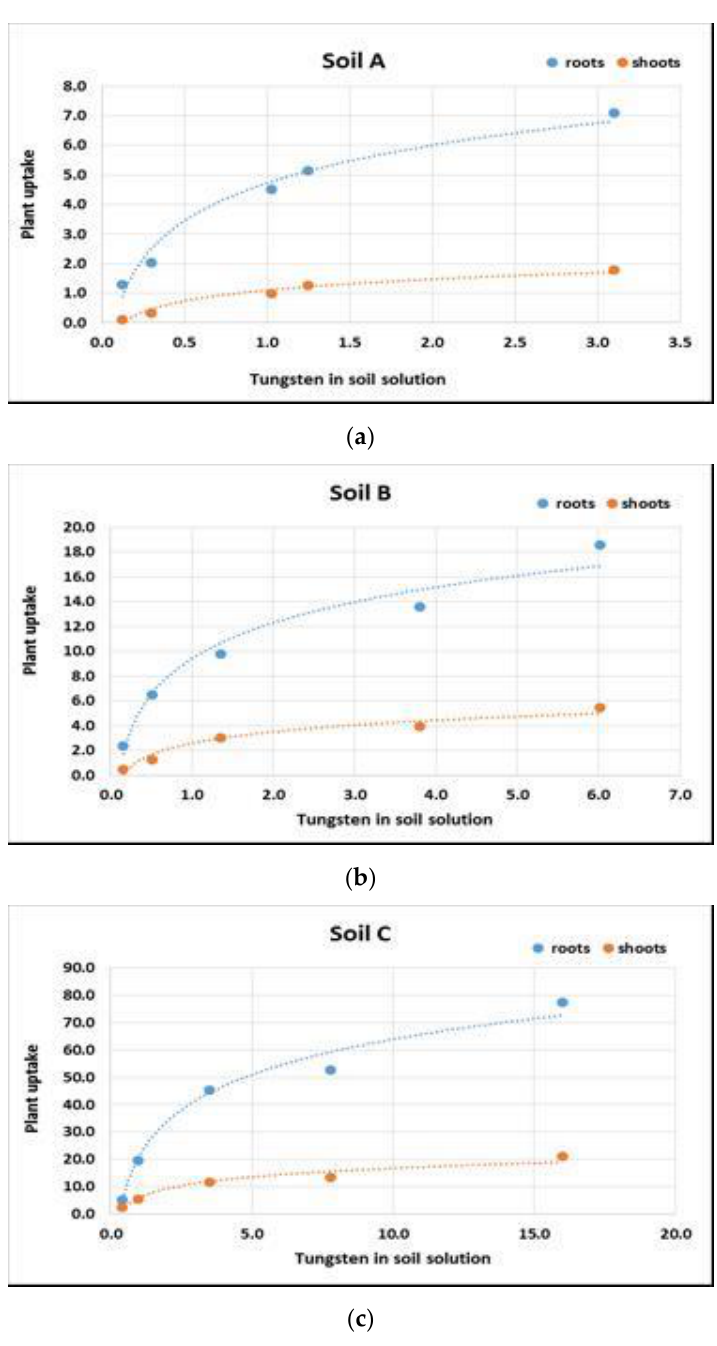
Figure 5. Trend of tungsten uptake for shoots and roots at increasing W concentrations in soil solution. Data are expressed as mg kg -1 . (a) Soil A; (b) Soil B; (c) Soil C.